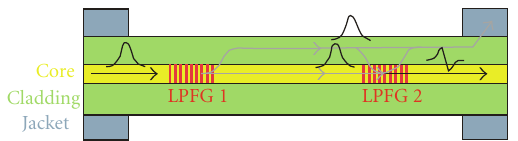
Figure 6: Schematics of the LPG-based common path interferome- ter for flat-top pulse shaping. The light is split by the first LPG, then propagates in the core and cladding modes with di ff erent speeds and is superimposed coherently using the second LPG.